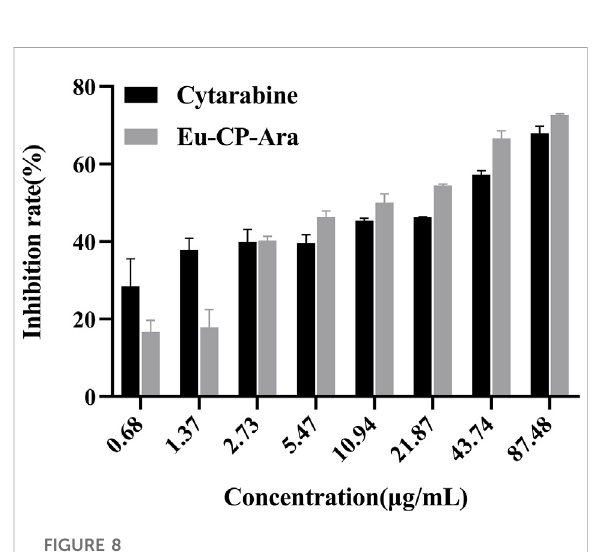
FIGURE 8 Inhibitory rates of cytarabine and Eu-CP-Ara at different concentrations on A549 cells (0.68, 1.37, 2.73, 5.47, 10.94, 21.87, 43.74, and 87.48 μ g/ml).